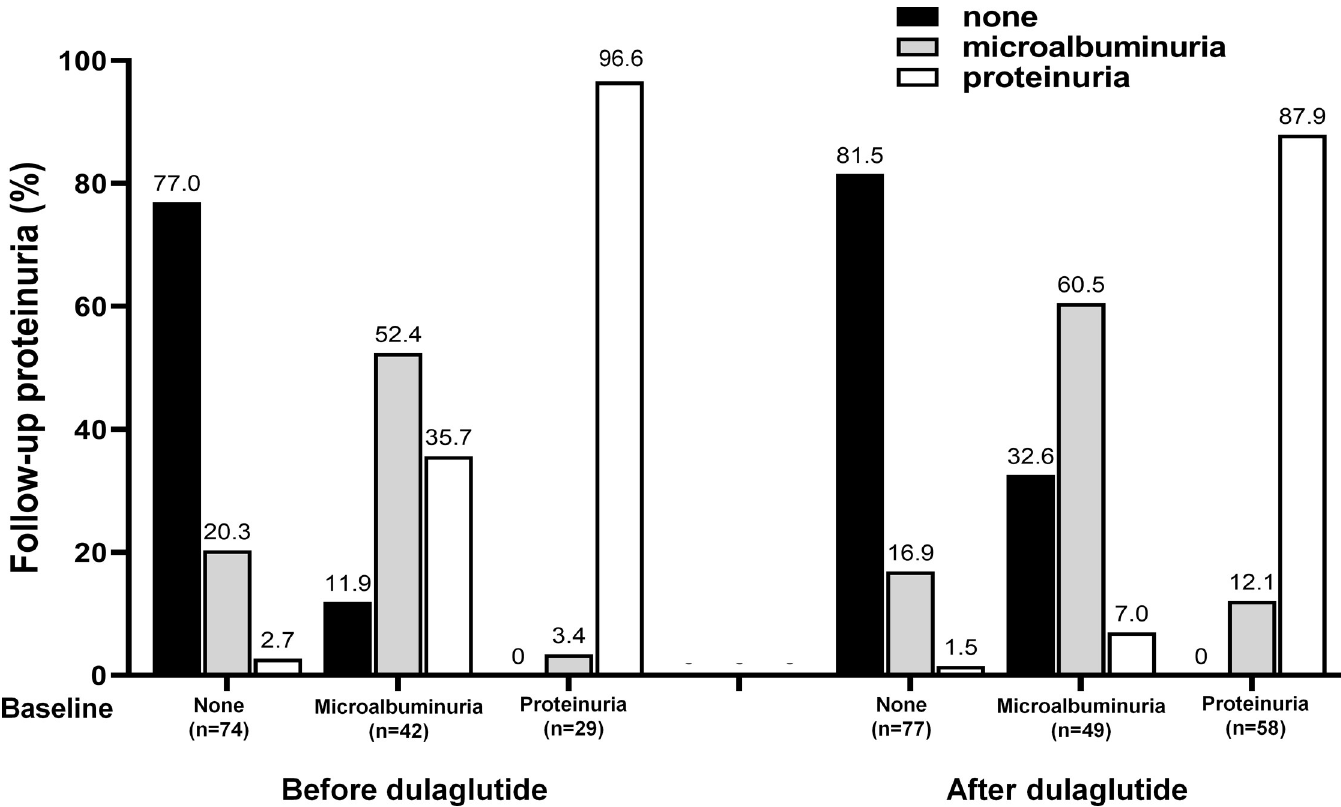
Fig 4. The incidence rate of progression from microalbuminuria to proteinuria with dulaglutide use. The rate of proteinuria development from microalbuminuria was significantly reduced after the use of dulaglutide. Urinalysis data were available in 145 and 184 cases before and after the use of dulaglutide, respectively.